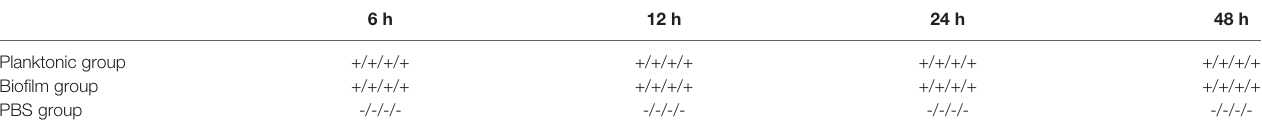
TABLE 5 | Isolation of Lactococcus garvieae from mullet spleens on TSA agar. Con fi rmation of L. garvieae using 16S rRNA PCR.